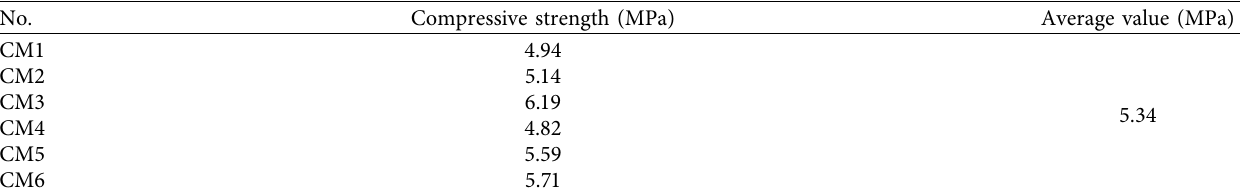
Table 3: The compressive strength of mortar.